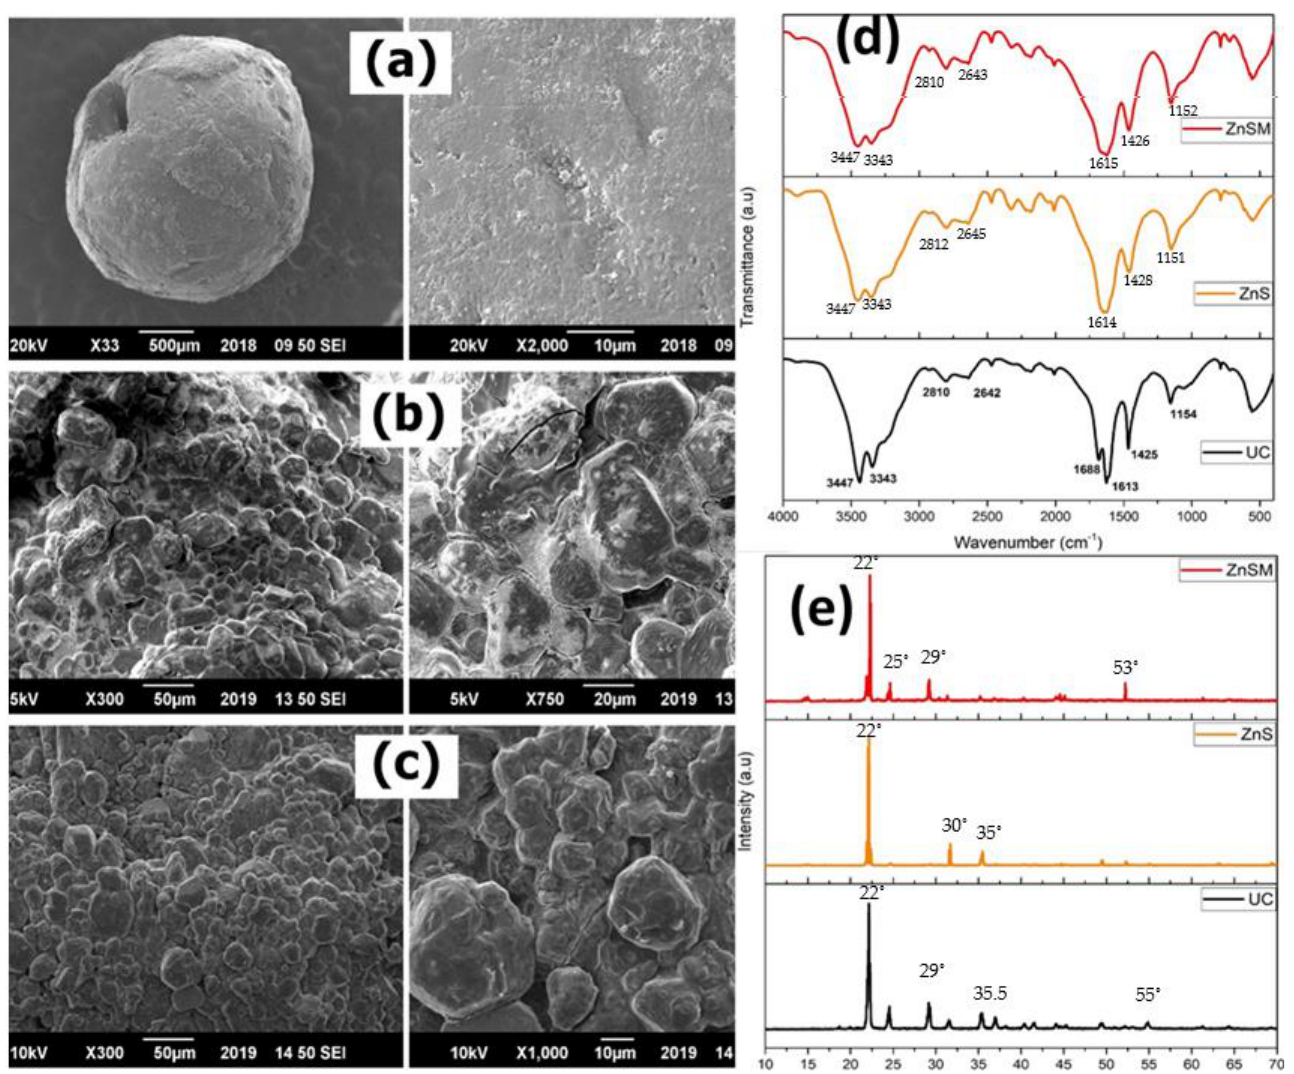
Figure 2. SEM micrographs of uncoated urea fertilizer ( a ), coated with zinc sulphate ( b ) and zinc sulphate + molasses ( c ). Fourier transform infrared (FTIR) spectra ( d ) and X-ray diffractogram ( e ) of coated and uncoated urea fertilizers.